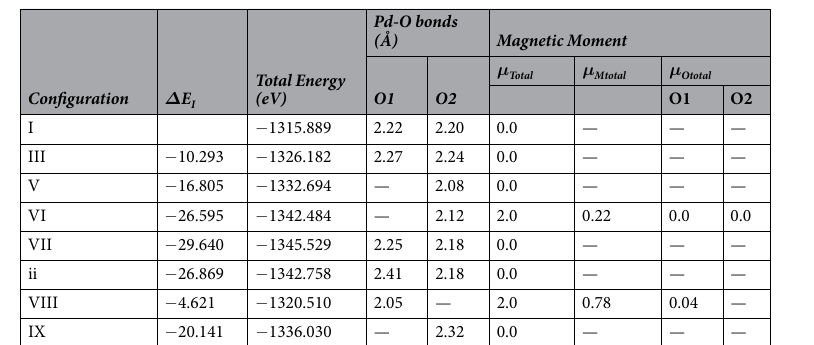
Table 1. Bonding Parameters and Magnetization values of configurations in Fig. 1 † . † Pd is bonded to surface oxygen O1 and O2. Magnetization spread over other surface atoms is not listed in the table. The data for configurations I are from ref. 18 and III and VIII are from ref.